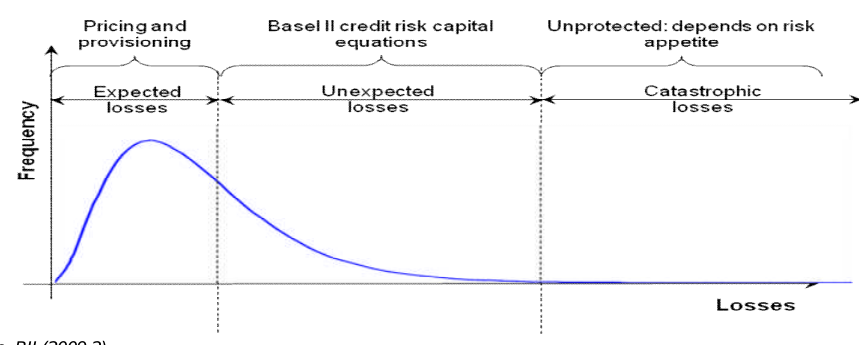
Important features of a typical credit loss